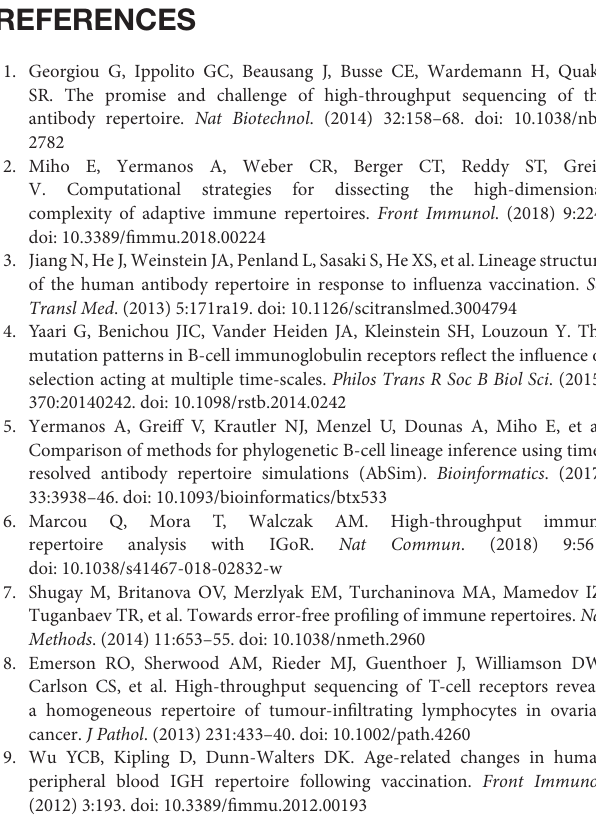
Supplementary Table 1 | The Pipeline repertoire. The most common features for each pipeline are written into each square. Check symbols, a feature performed by the corresponding tool but there is scarce, or no detailed information about how the process is performed; empty squares, the corresponding feature is not included in the specific tool at the moment of assembling the table. The table can be downloaded in a spreadsheet format at